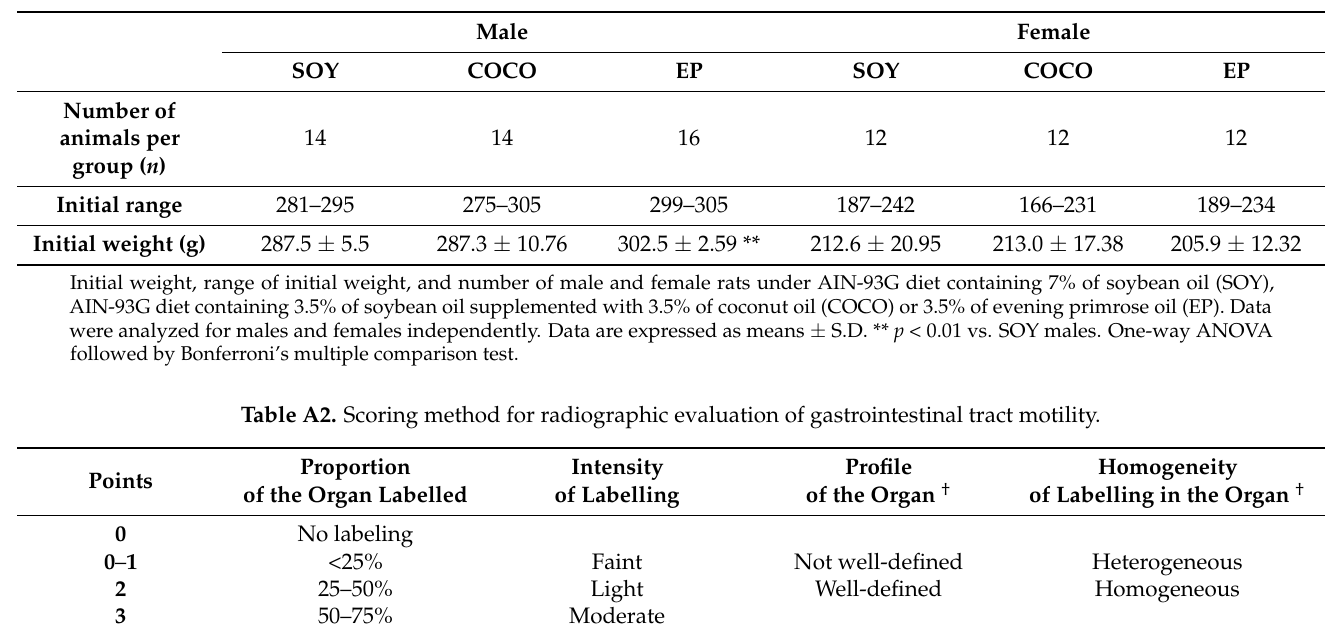
Table A1. Initial weight and number of male and female rats used in the study.